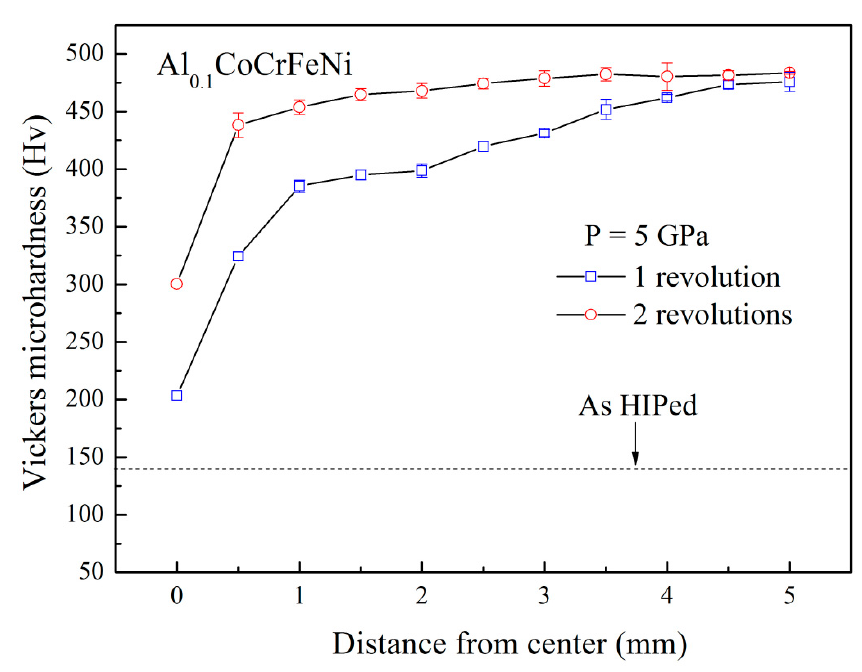
Figure 10. Vickers microhardness plotted against the distance from the center for the sample, data from [67].